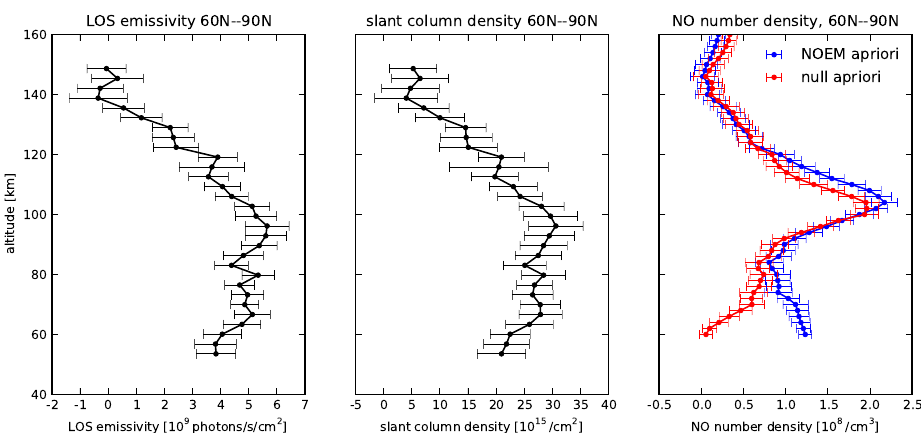
Fig. 4. Zonal mean (60 ◦ N–90 ◦ N) integrated NO emissivity profile (3 February 2010) (left panel), zonal mean fitted slant column densities (middle panel), and zonal mean NO number densities (right panel) using the NOEM model as a priori input (blue line) and without prior assumptions (red line). The error bars show the 3 σ confidence interval.